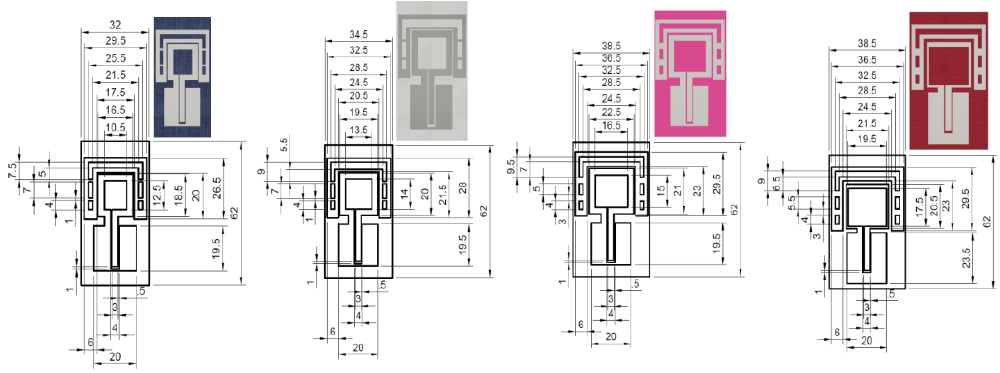
Figure 9. Configuration of the antennas with denim, cotton, polyamide-elastane and polyester substrates.